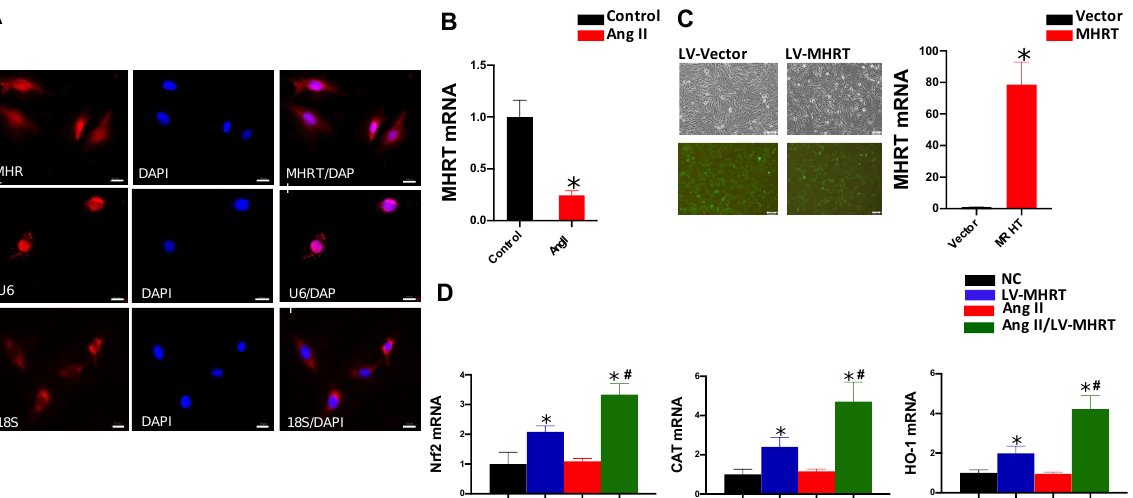
Figure 4. Overexpression of MHRT activates Nrf2 in AC16 cardiomyocytes. ( A ) The location of MHRT in AC16 cells was assessed by FISH. U6 and 18S represent the positive control for the nucleus and cytoplasm, respectively (Scale bar, 20 µ m). ( B ) AC16 cells were stimulated with Ang II (100 nM) for 24 h and mRNA was harvested for analysis of MHRT transcription by qPCR. ( C ) AC16 cells were transfected with GFP (NC, LV-Vector) or MHRT (LV-MHRT) using lentivirus. At 48 h after transfection, Puromycin was added to select for purely transfected cells. The transfection efficiency was assessed by fluorescence observation (Scale bar, 100 µ m) and qRT-PCR analysis. ( D ) AC16 cells of LV-MHRT and NC (LV-Vector) were stimulated with Ang II (100 nM) for 24 h and mRNA was harvested to analyze the transcription of Nrf2, CAT and HO-1 by qPCR. Data are presented as the mean ± SD ( n = 6). * p < 0.05 vs. NC, # p < 0.05 vs. Ang II.